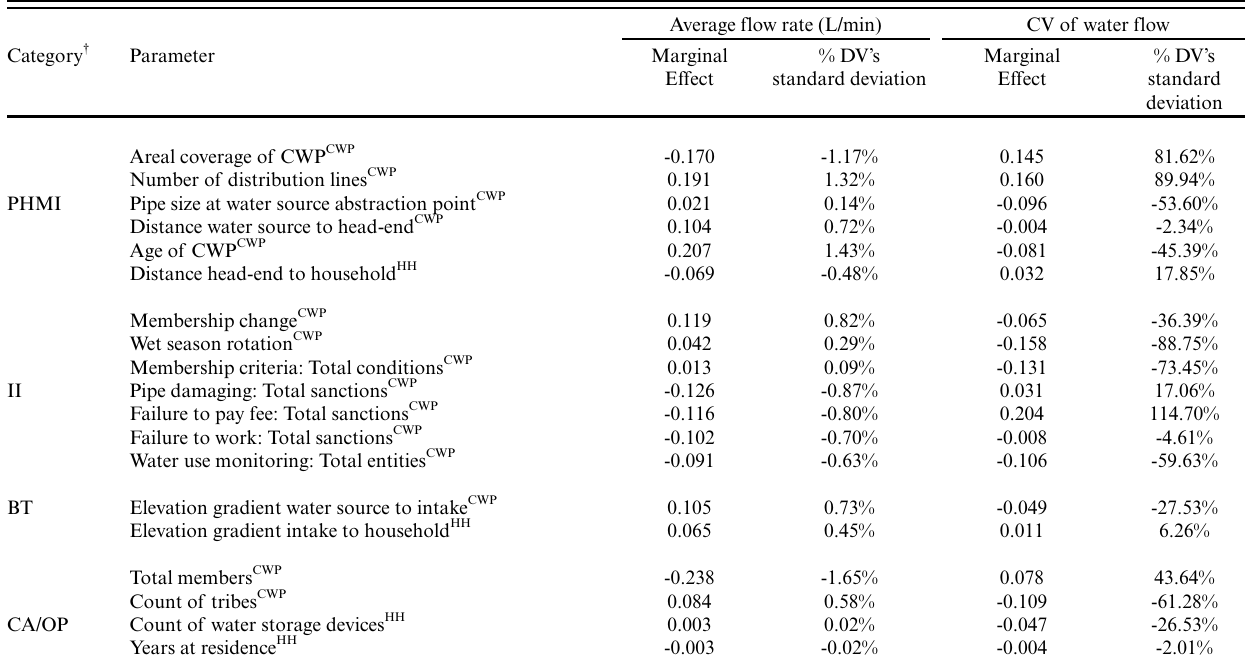
Table 9. Marginal